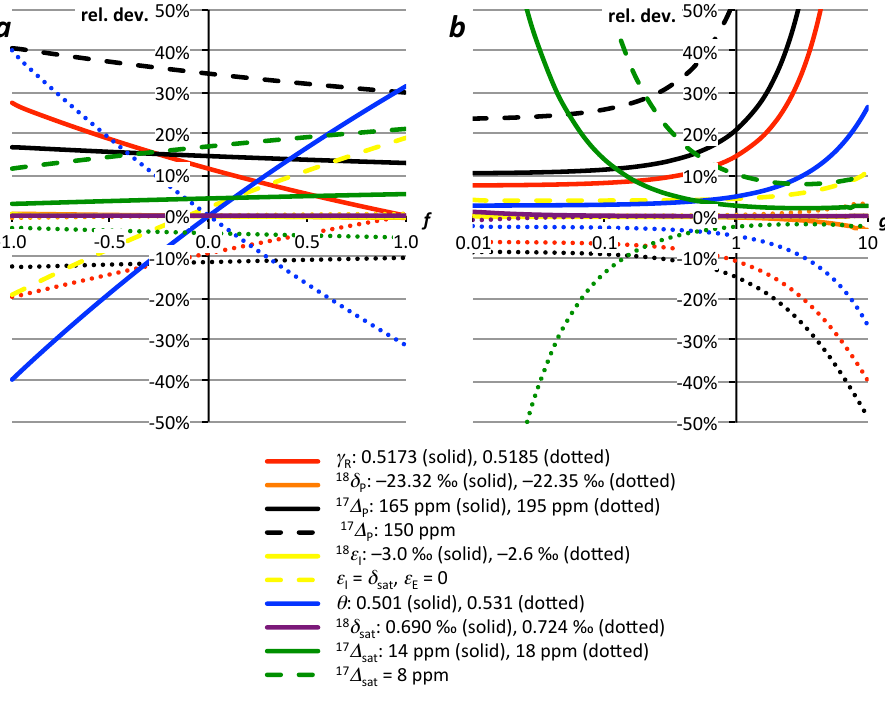
Fig. 2. Relative deviation of g from the base case (see Table 2) for different parameters in Eq. (48). Panel (a) corresponds to g = 0.4 and a range of f from − 1.0 to +1.0 (negative values correspond to net heterotrophy, positive value to net autotrophy). Panel (b) corresponds to f = 0 . 1 and range of g from 0.01 to 10 (logarithmic